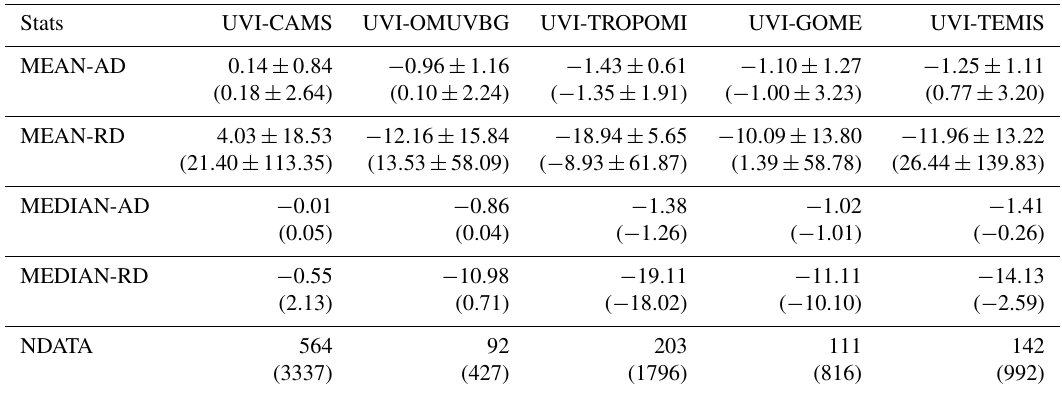
Table A2. Mean and median absolute and relative differences between CS-UVI satellite/model measurements and CS-UVI-RADIO at Antananarivo. Mean and median absolute and relative differences between ALL-SKY-UVI satellite/model measurements and ALL-SKY- UVI-RADIO at Antananarivo are in